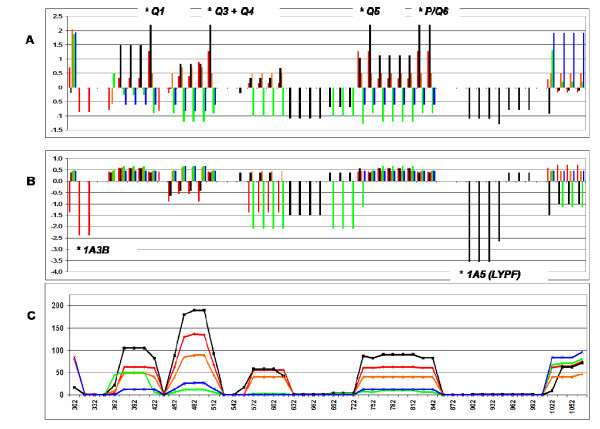
Sliding window plot of (A) Tajima's D values, (B) Fu and Li's D* values and (C) nucleotide diversity for the entire sequenced region. Statistics were calculated for overlapping windows of 60 bp, placed at 15 bp intervals along the sequence. * P < 0.05.